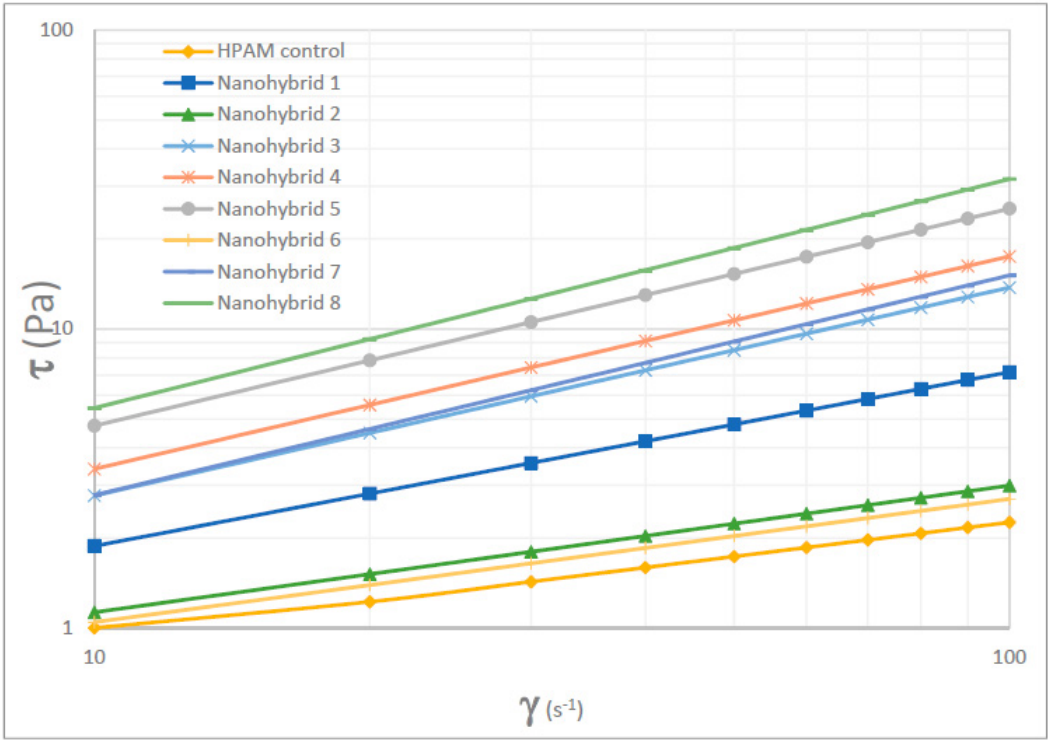
Figure 7. A plot of the shear stress vs. shear rate curve for the formulated nanohybrid compositions and HPAM polymer solution. T = 85 ◦ and HPAM polymer solution. T = 85 o C.